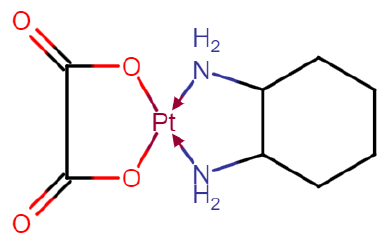
Figure 1. Chemical structure of oxaliplatin (OXP).